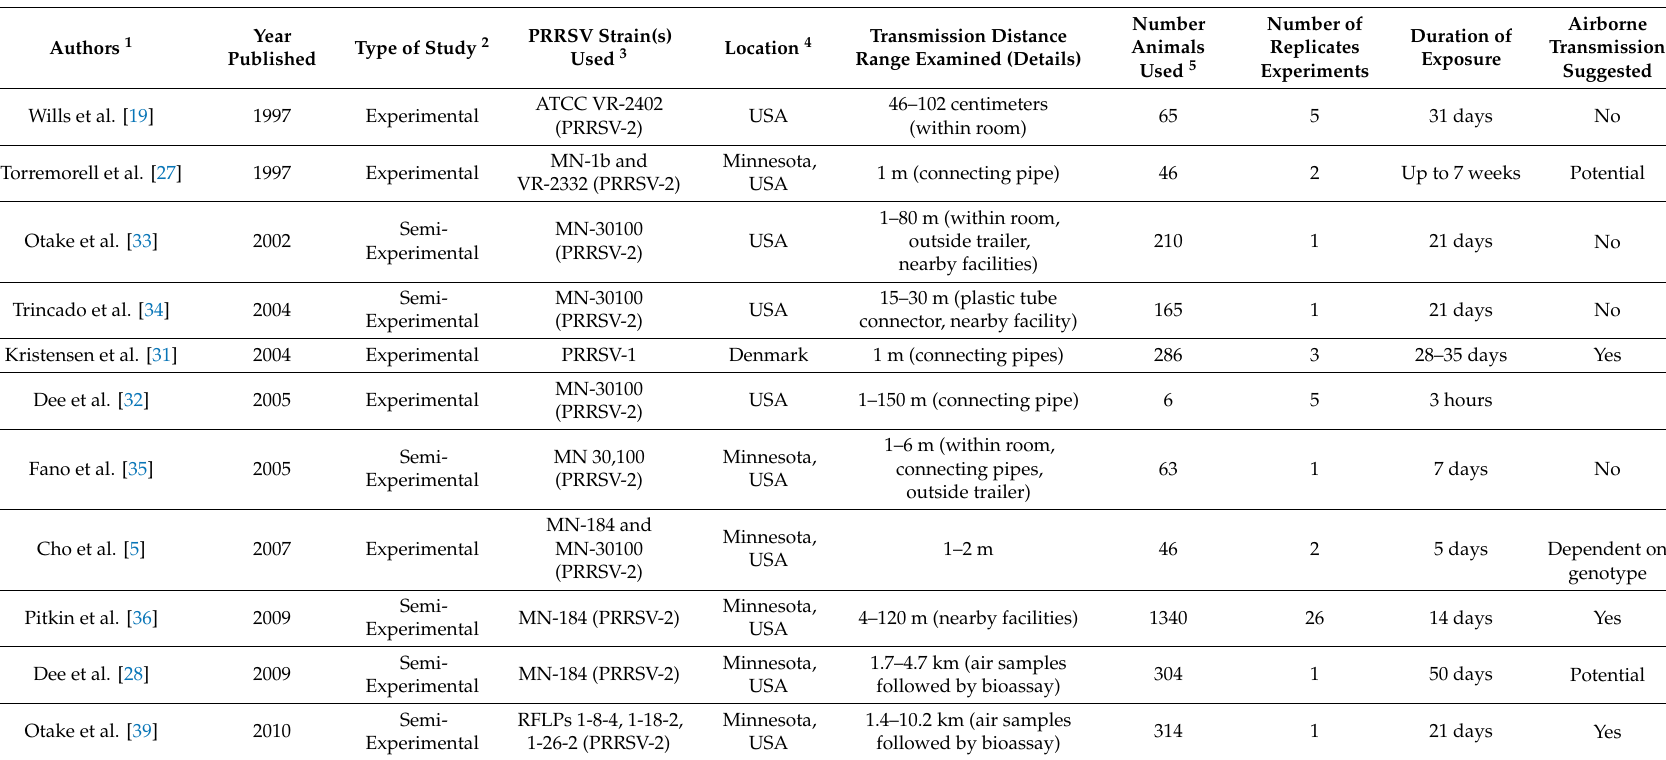
Table 1. Compiled list and main characteristics of peer-reviewed publications that directly aimed to assess airborne transmission of porcine reproductive and respiratory syndrome virus (PRRSV) within and / or between swine